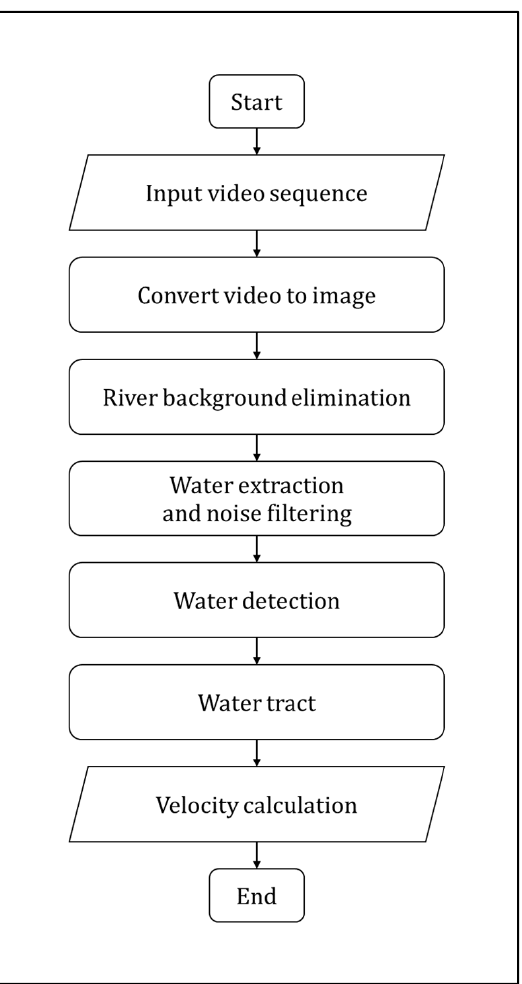
Figure 2. Doppler processing for characterizing physical features of the water channel. Doppler processing is the main technique for increasing the signal to clutter ratio (SCR). To increase the SCR, the signals must be frequency separable. The moving target signal can be separated from the clutter echoes in the frequency domain [36]. The clutter is relatively stationary (wind moving trees, flowing water, etc.) and, therefore, contributes little or nothing to the Doppler shift of the return echo. Thus, we can apply Doppler processing to detect significant clutter. Doppler processing has two general cases: moving target indication (MTI) and pulse Doppler processing. MTI requires fewer calculations but can only detect the presence of a moving target. MTI cannot identify if there is more than one target per range bin or what the speed of that target is. The main advantage of an MTI is less complexity and fewer calculations. On the other side, pulsed Doppler processing can detect a target similarly, but it can also measure the Doppler shift and, from this, determine the velocity of the target. A further advantage of pulsed Doppler processing is the detection of multiple targets, with the only condition that they are separated by a sufficiently large Doppler shift. These advantages bring with them the trade-off of increased computation and complexity. An MTI may only be implemented by making use of temporal data on many coherent, i.e., slow time, pulses, so the consecutive slow time intervals will be filtered out in the internal composition of digital beamforming using a high pass filter. This attenuates the clutter that is confined around 0 Hz. Finally, a threshold is applied to the time data and a decision is made on the detection.